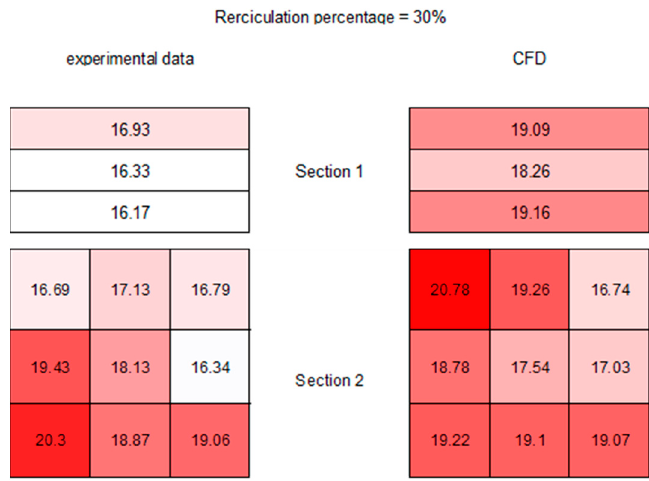
Figure 9. Comparison between experimental and CFD data for 30% WGR—O 2 mole fraction.